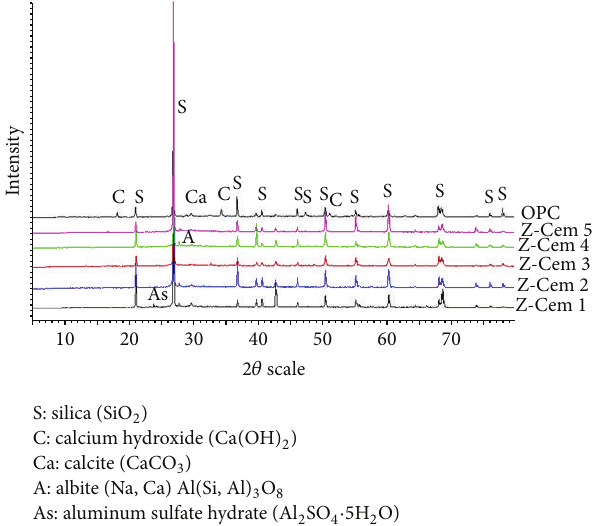
Figure 6: XRD pattern of the mortars at 28 days of curing